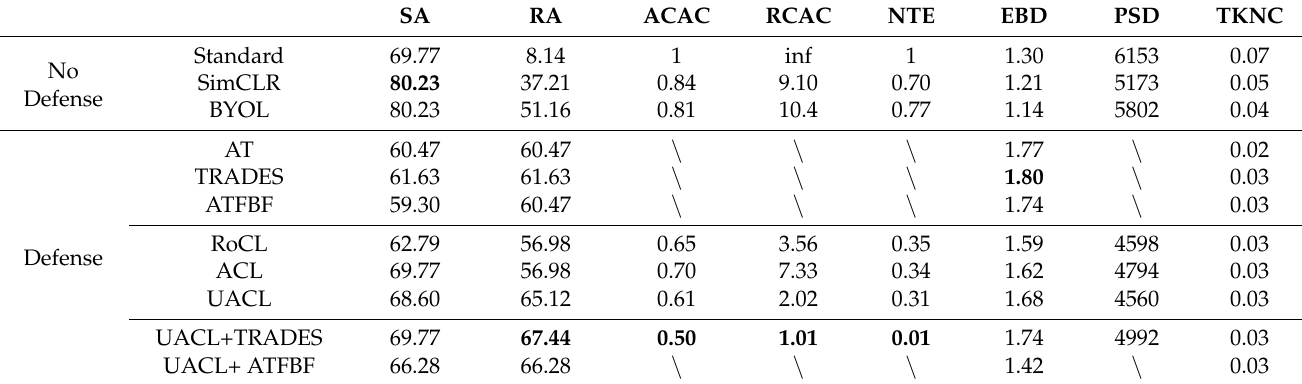
Table 14. Comprehensive evaluation of models (ResNet18) with no-defense or defense methods against PGD attacks (attack strength is 8/255 in L ∞ norm) in FUSAR-Ship dataset. Because the robust accuracy of some models is not less than the standard accuracy, some parameters cannot be